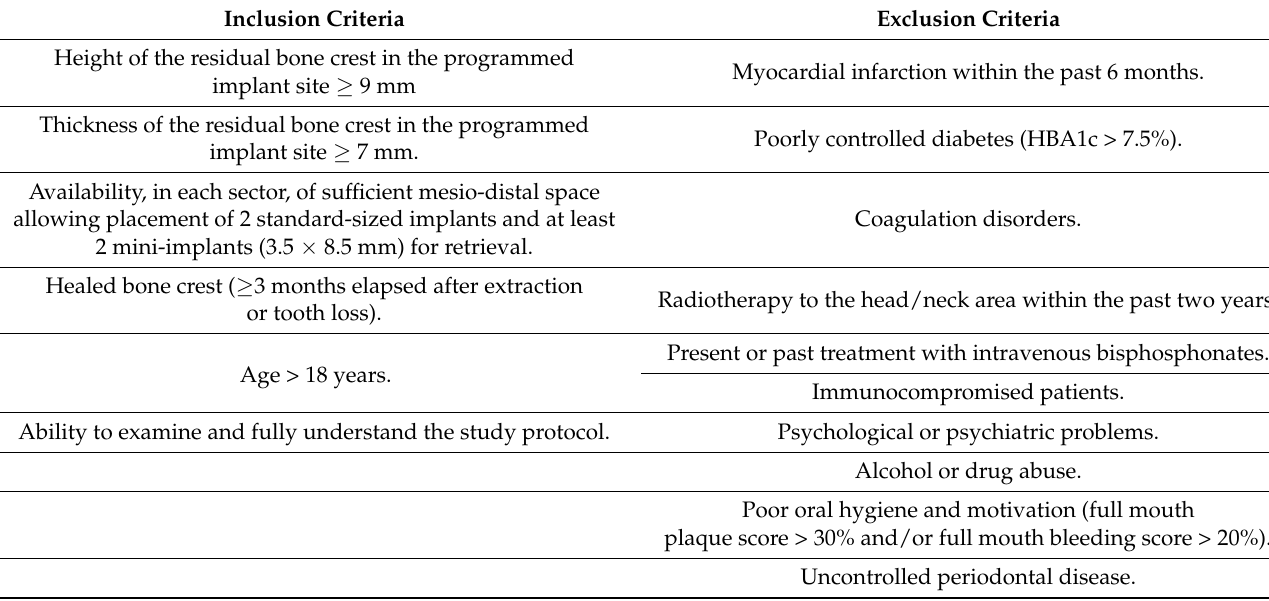
Table 1. Inclusion and exclusion criteria